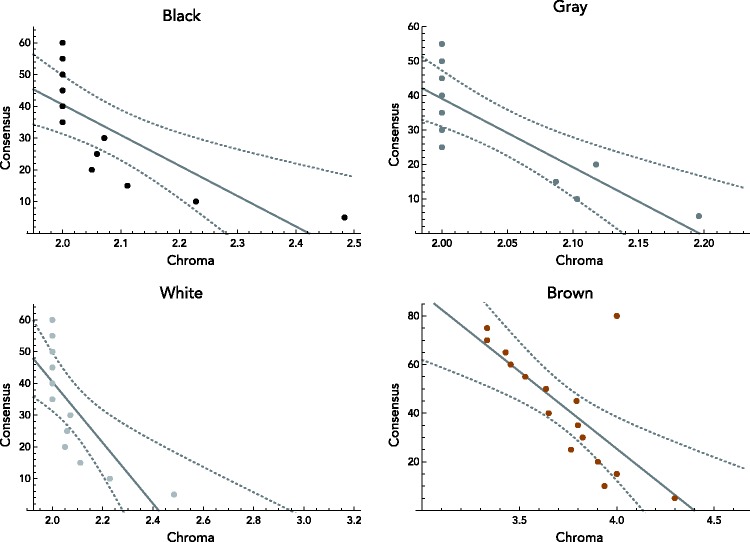
Plots of linear models with chroma as negative predictor of consensus. Dotted lines indicate 95% confidence bands.